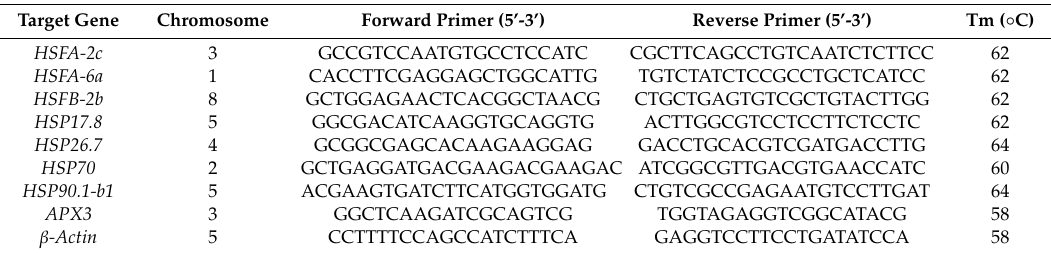
Table 1. Primer sequences and annealing temperature of analyzed